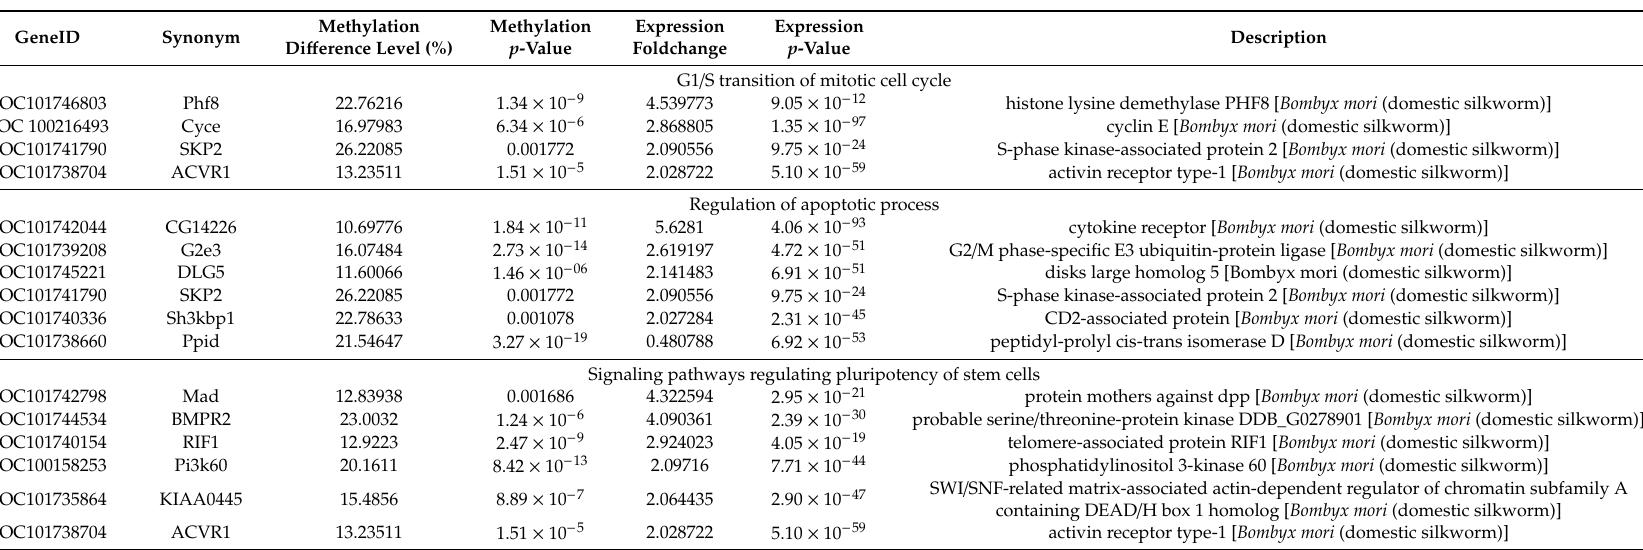
Table 5. Methylomes- and transcriptome-associated genes involved in cell cycle and